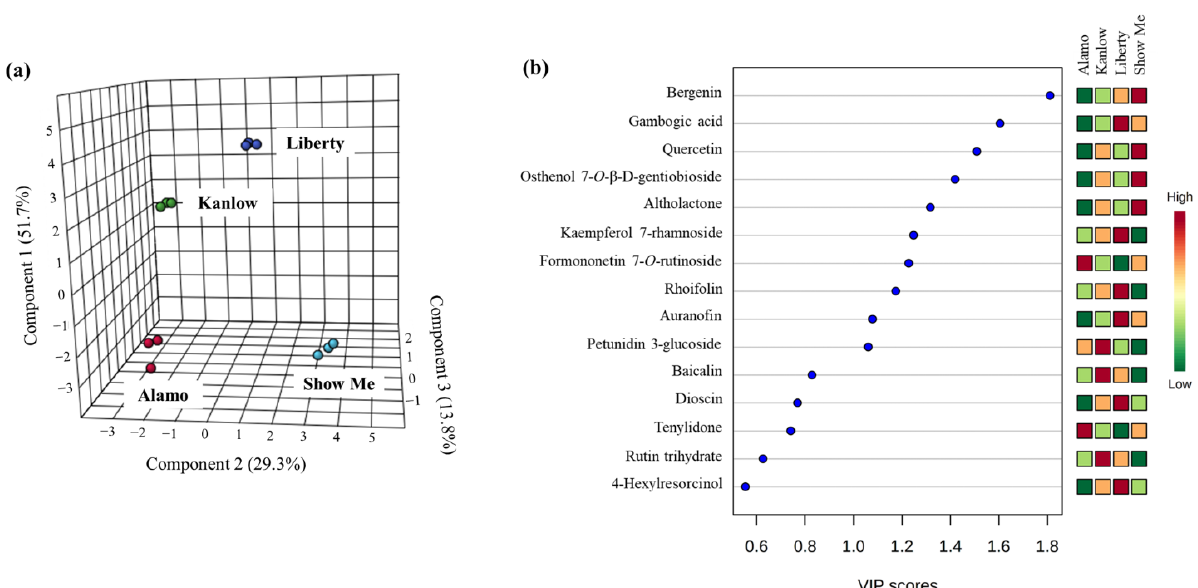
Figure 6. Partial least-squares discriminant analysis (PLS-DA) revealed differences in the metabolic profiles of the switchgrass cultivars. ( a ) PLSDA plot, ( b ) variable importance in projection (VIP) score plot to the component 1. Circles with the same color represent replicates of the metabolic profiles for each cultivar.